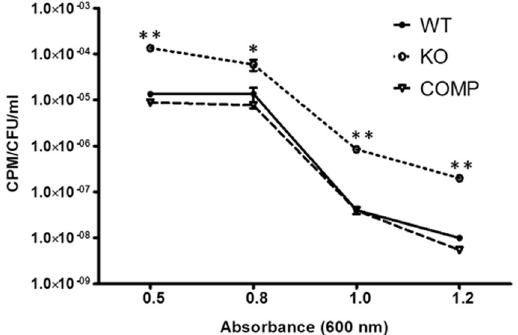
Figure 3. The levels of DNA synthesis in WT, MDP1-KO, and COMP strains. Cultures were grown to OD 600 values of 0.5, 0.8, 1.0, and 1.2, and synthesis of nucleic acids was chased for 30 min by incorporation of 3 H-uracil. RNA was hydrolyzed by KOH and the level of DNA synthesis was determined by scintillation counting. The levels of DNA synthesis was expressed as the count of DNA per min per CFU per ml. ANOVA was used to analyze the data and P-values < 0.05 (indicated by * ) were considered significant. The experiment was repeated in